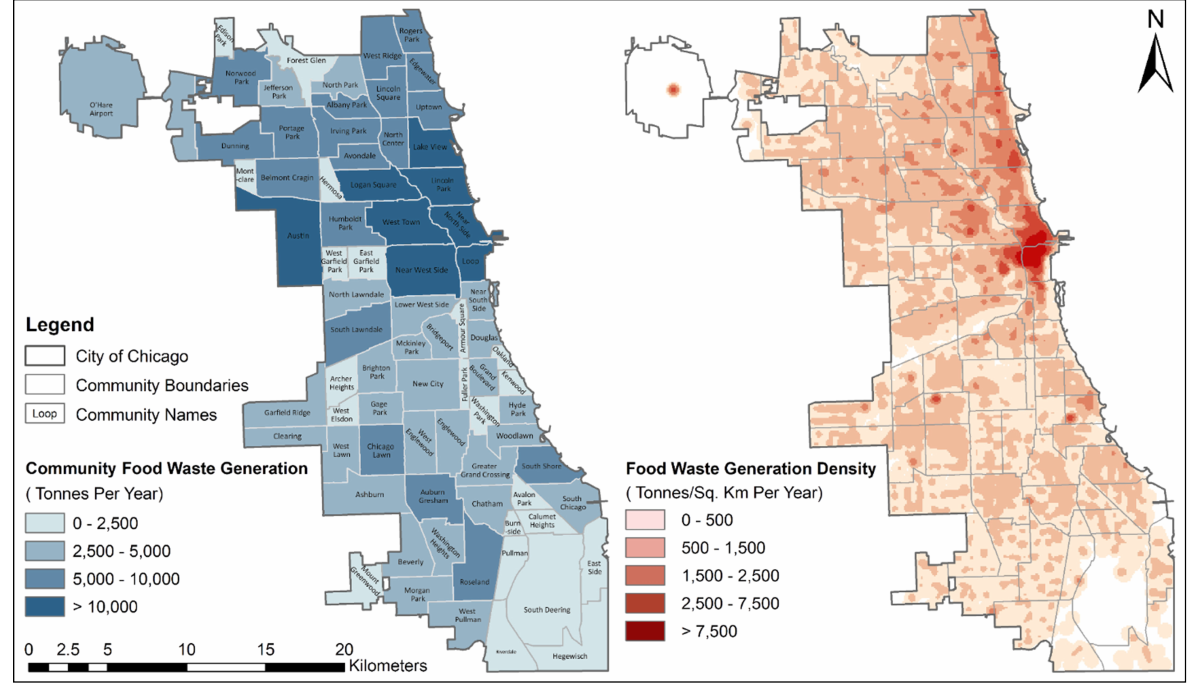
Figure 2. Food Waste Generation in Chicago